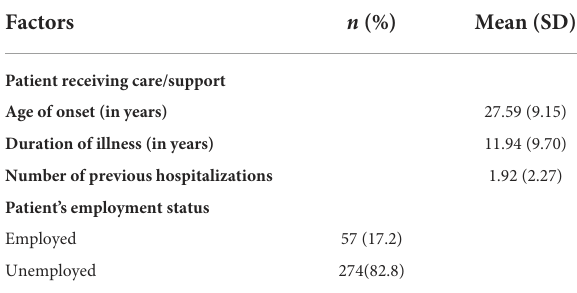
TABLE 1 Sociodemographic characteristics of caregivers of patients with schizophrenia ( n =